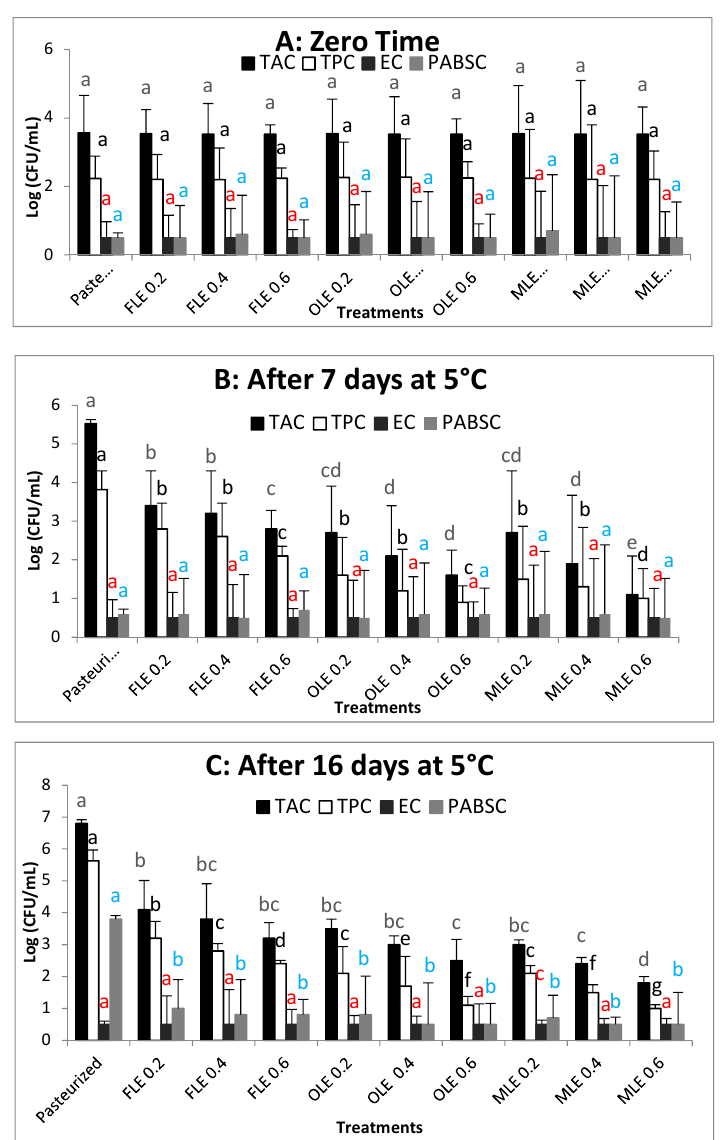
Figure 2. Microbial profile analysis (TAC, TPC, EC, and PABSC) of pasteurized buffalo milk samples enriched with different concentrations of FLE, OLE, and MLE during 16 days of storage at 5 °C. ( A ) zero time, ( B ) after 7 days at 5 ◦ C and ( C ) after 16 days at 5 ◦ C. Columns at the same microbiological parameter (TAC, TPC, EC, and PABSC) are labeled to show significant di ff erences between di ff erent treatments by using di ff erent letters. Vertical bars show the standard error of the samples